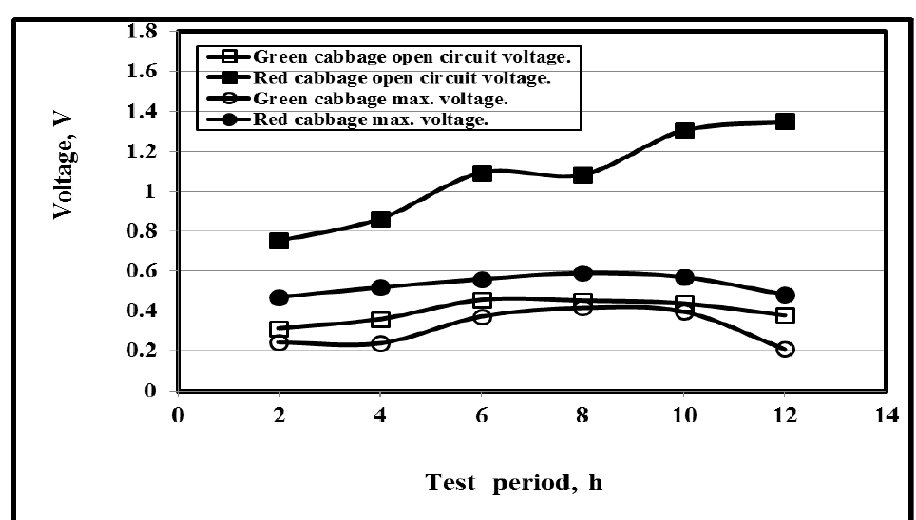
Figure 11. Vm and Voc/ test period relation for RC and GC solar cells. The relationships between circuit current density and voltage as functions of test periods and temperature are shown in Figures 12 and 13 for the RC and GC-based solar cells. For both test periods and temperatures, the GC-based cells’ maximum current trends were higher than those of the RC-based cells. This was due to the presence of larger amount of the green matter necessary for photosynthesis in green cabbage than in red cabbage, which is in agreement with the results in previous reports [68].